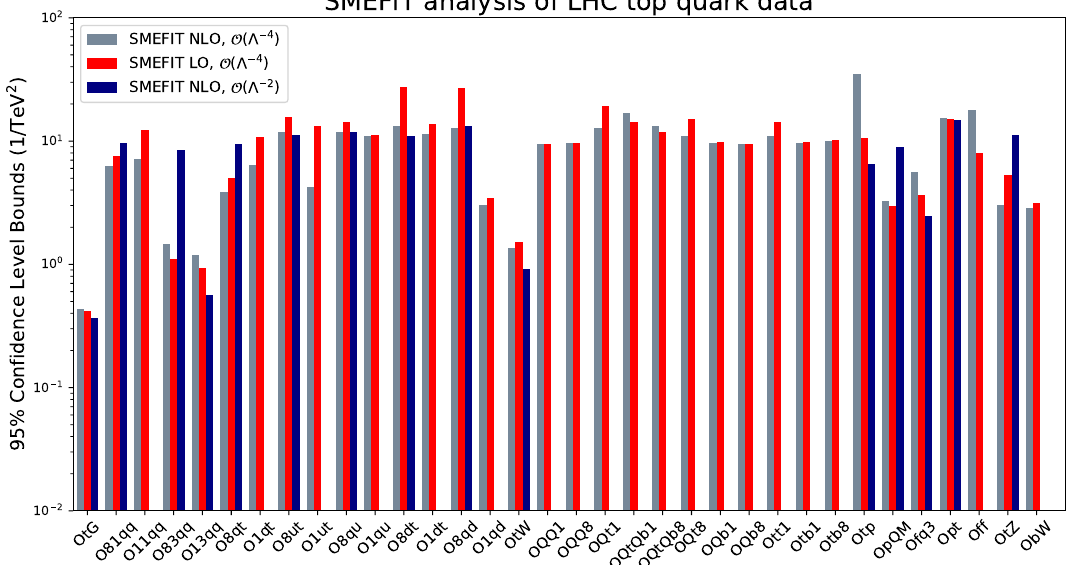
Figure 21 . Same as (cid:12)gure 19, now comparing the baseline (cid:12)t results reported in table 8 with those from table 9 based on the corresponding (cid:12)ts where (i) only LO QCD e(cid:11)ects are included in the SMEFT contributions and (ii) only the linear the quadratic terms). Note that, at the level of the absent and we quote no bounds for the four-heavy-quark